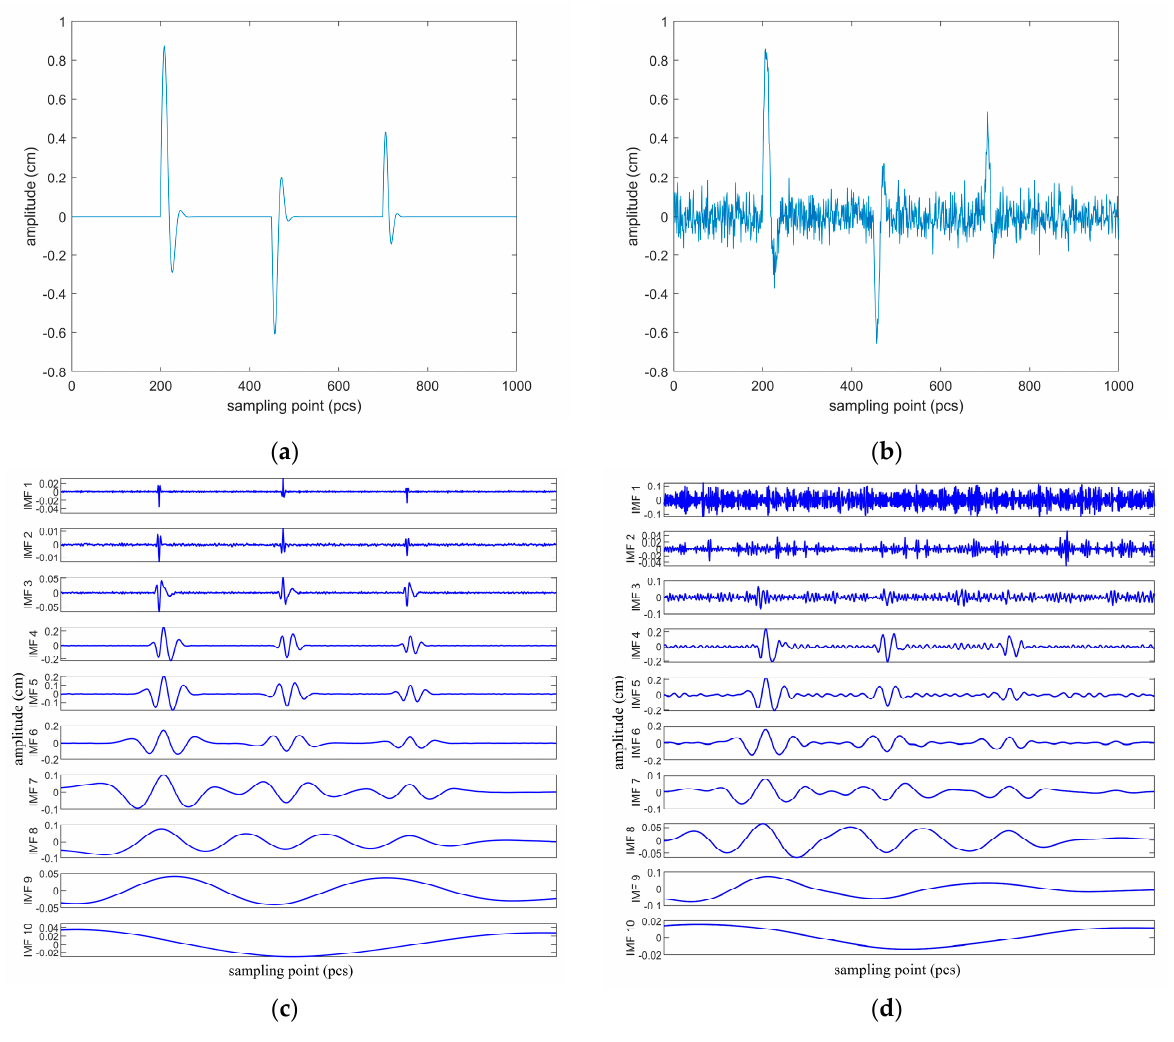
Figure 4. Comparison of the synthetic data and noisy data. ( a ) Synthetic data; ( b ) Noisy data; ( c ) IMFs of synthetic data; ( d ) IMFs of noisy data.